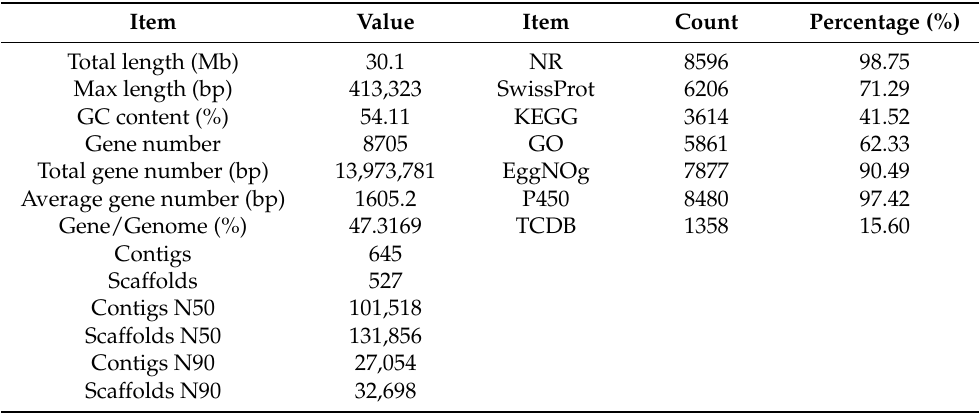
Table 1. Genomic assembly and functional annotation of C. pseudotenuipes